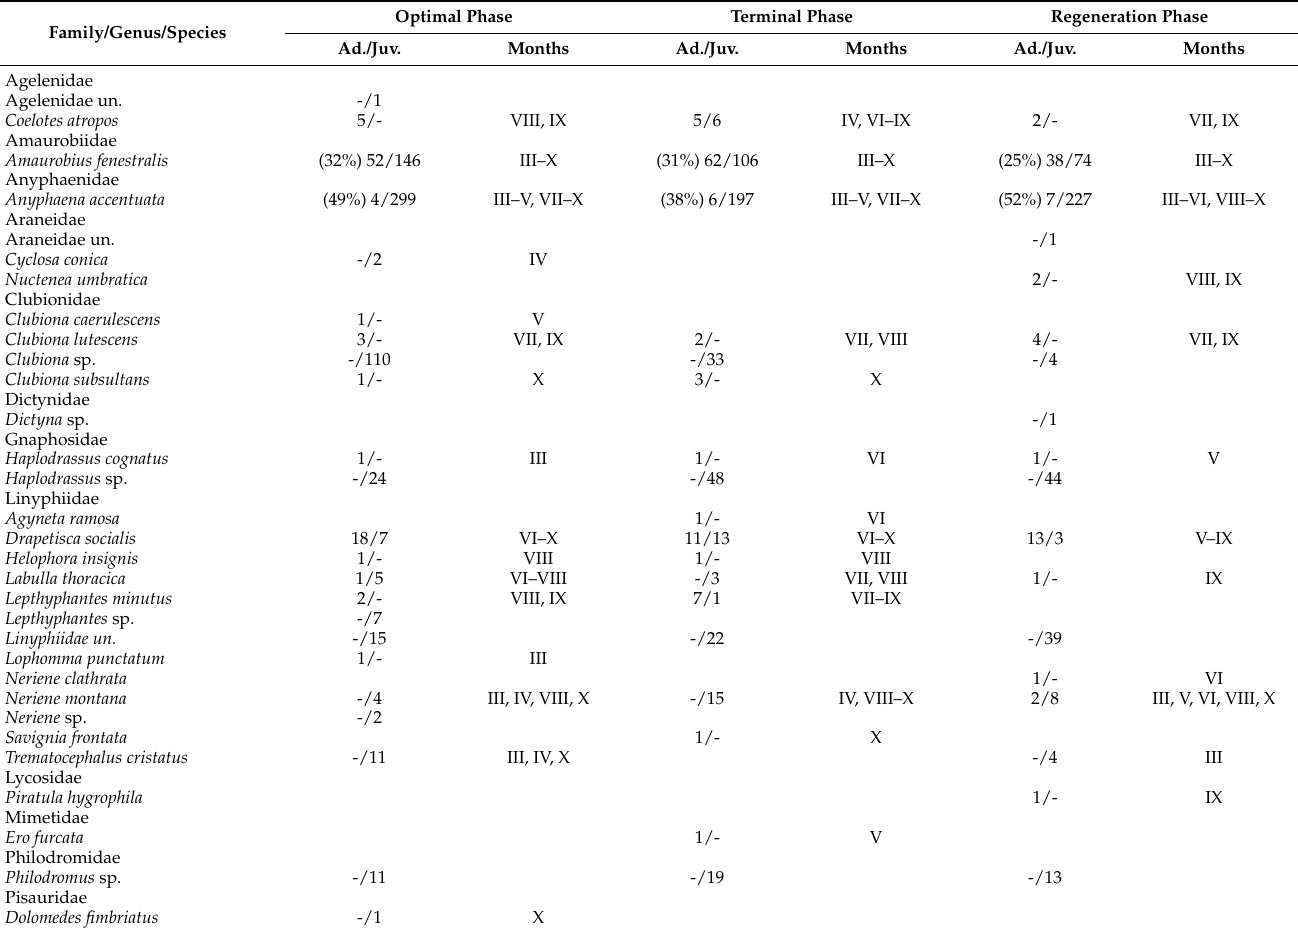
Table 4. Spiders collected on tree trunks in three developmental phases of oak–lime–hornbeam stands in the Białowie˙za National Park (spider families, genus and species in alphabetical order). The percentages presented in parentheses, next to the number of individuals, show the proportion of each species. All individuals identified to the species level were included in the percentage composition, but values are only shown for species that reached at least 5%. Abbreviations: Ad./Juv.—number of adult/juvenile spider individuals, un.—individuals identified only to the family level. Roman letters indicate the months in which a given species was